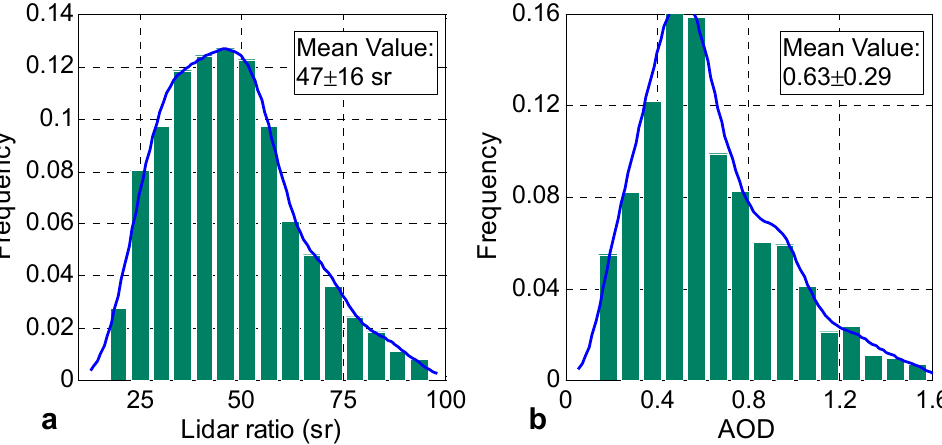
Figure 6. Frequency distribution of ( a ) lidar ratios and ( b ) AODs; the blue solid lines represent the fitting curves.